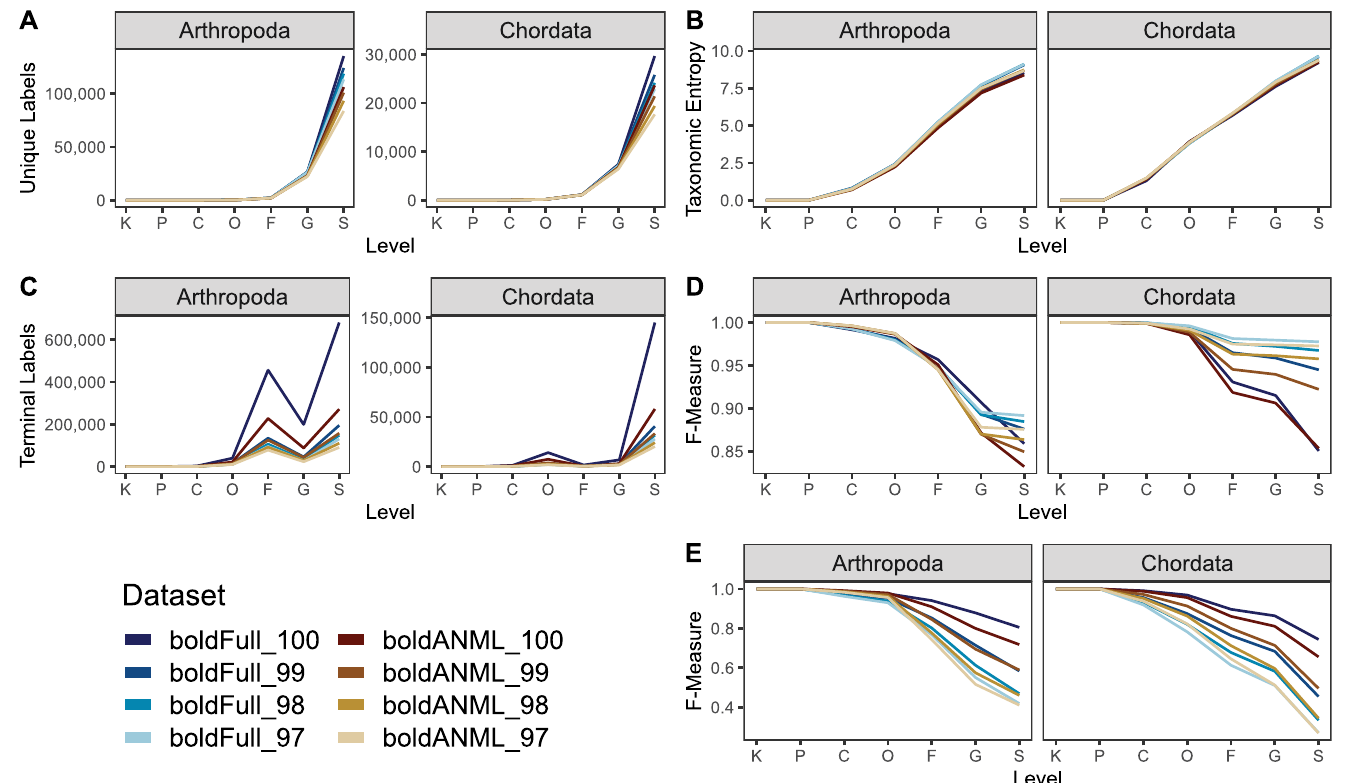
Fig 11. Comparison of taxonomic information and simulated classification accuracy from BOLD COI gene database for available arthropod and chordate sequences. Differences in datasets reflect whether sequences were trimmed to a particular primer region (boldANML) or not (boldFull), and whether sequences were dereplicated (_100) or clustered at a particular percent identity (_97, _98, _99). A, Number of unique taxonomic labels; B, Taxonomic entropy; C, proportion of unclassified taxa at each rank; D, optimal classification accuracy (as F-Measure) without cross-validation (simulating best possible classification accuracy when the true label is known but classification accuracy may be confounded by other similar hits in the database). E, Classification accuracy with cross-validation. Rank labels on x- axis: K = kingdom, P = phylum, C = class, O = order, F = family, G = genus, S = species.